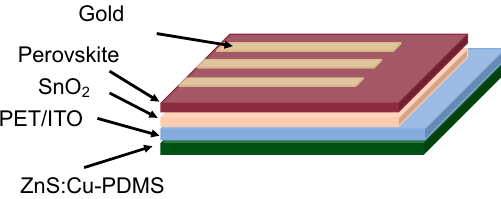
Figure 1. Schematics of the sensor device.